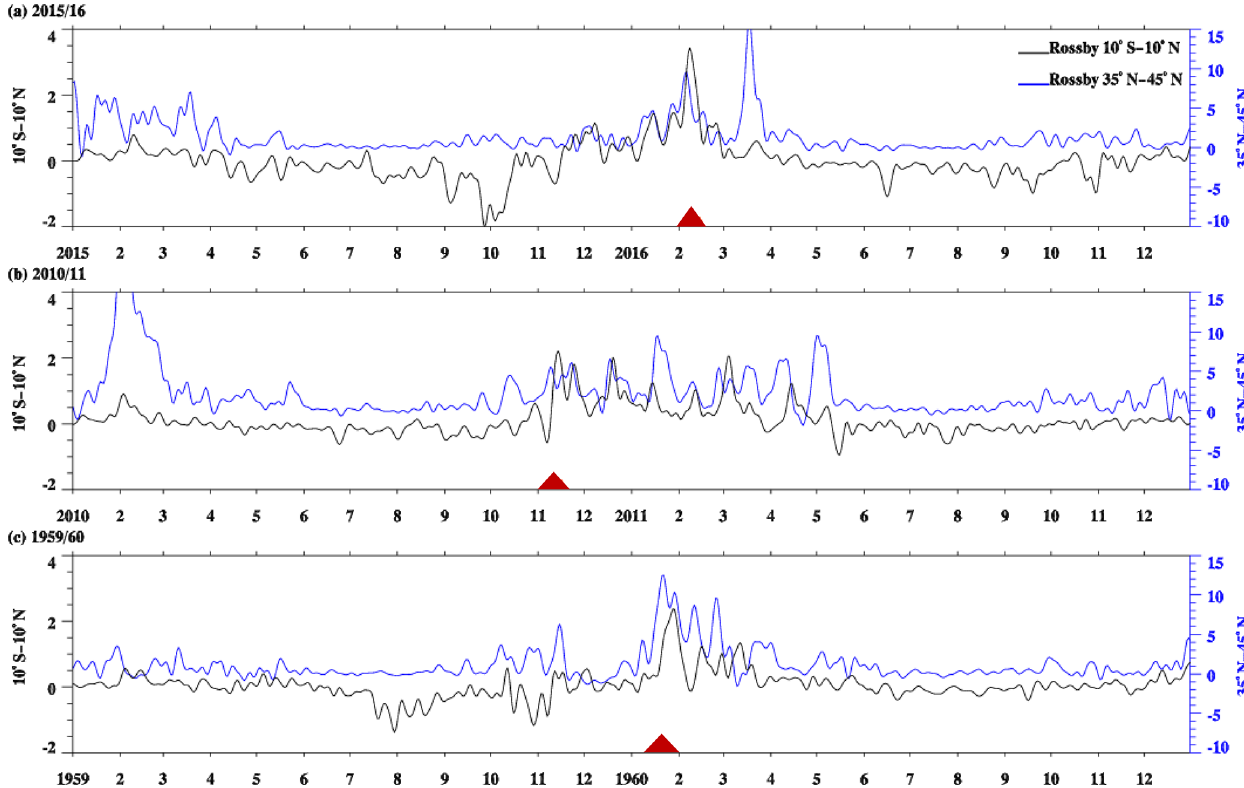
Figure 4. Temporal evolution of horizontal Rossby wave (with period of 5–70d) momentum flux anomaly averaged over 10 ◦ S–10 ◦ N (black lines) and 35–45 ◦ N (blue lines) during (a) 2015/2016, (b) 2010/2011, and (c) 1959/1960 at 40hPa. Red triangles in panels (a) , (b) , and (c) denote February 2016, November 2010, and January 1960,